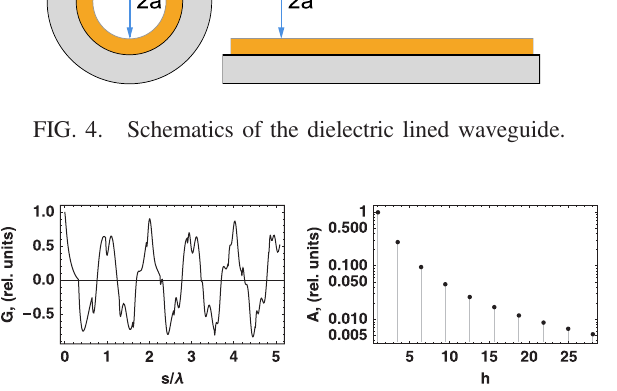
FIG. 5. Green ’ s function (left panel) and spectrum (right panel) normalized on the maximum values for the case of a dielectric lined copper tube with Δ ¼ 200 μ m. Here h is the harmonic number, λ is the wavelength of the harmonic with the maximum amplitude.